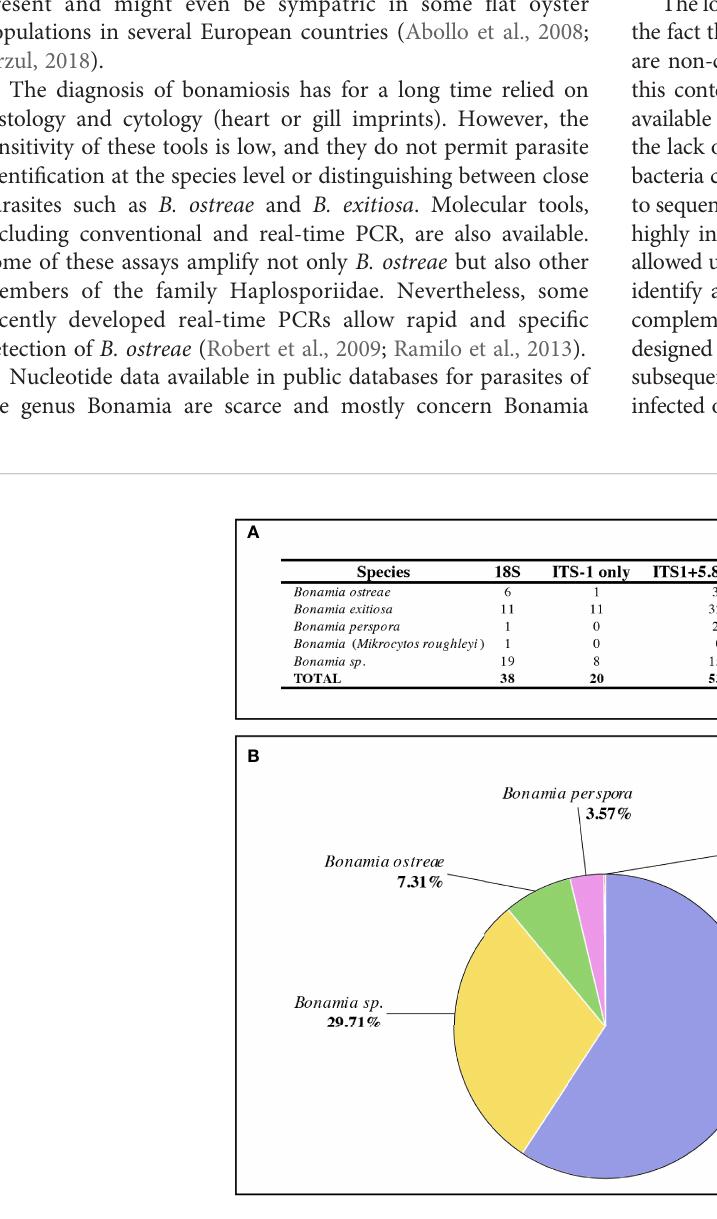
Frontiers in Cellular and Infection Microbiology |